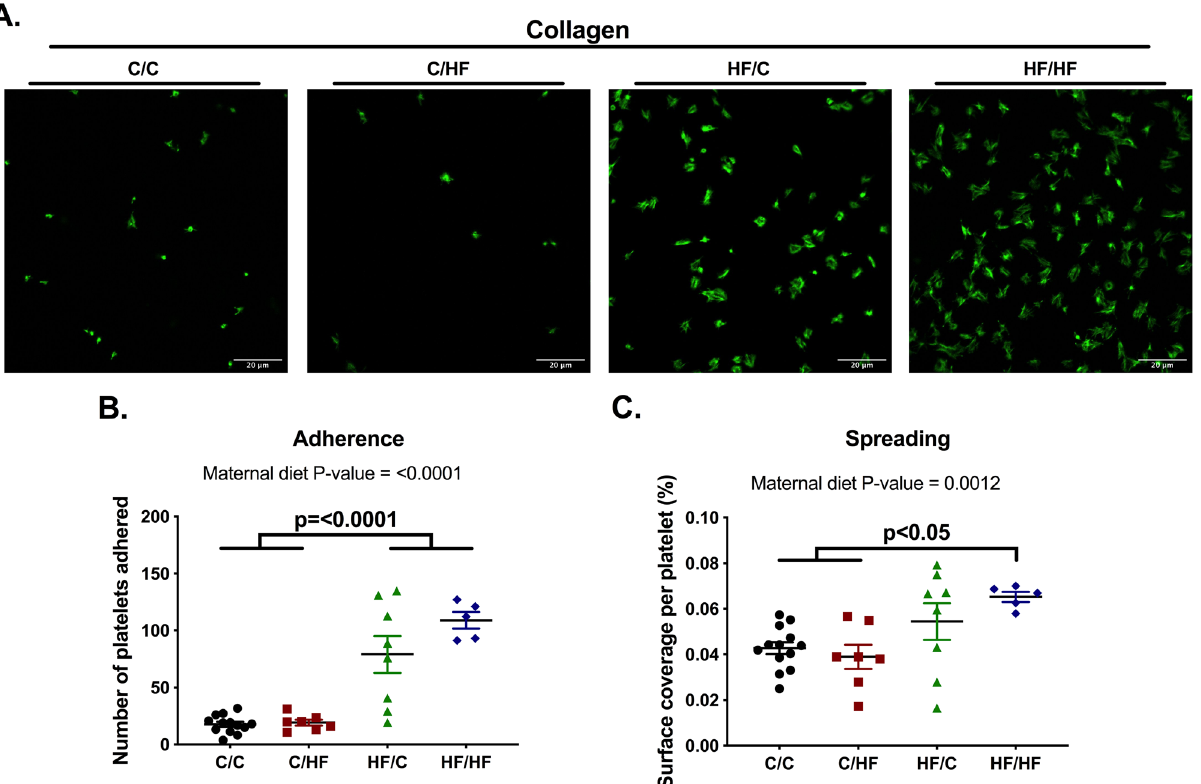
Figure 3. Maternal high-fat diet increased platelet spreading over collagen in male offspring. WP (2 × 10 7 platelets/mL) was left to adhere to coverslips coated with collagen and platelets fluorescently labelled for visualization. ( A ) Representative images of platelet spreading of each group. ( B ) Quantification of platelet adherence as number of platelets per field. ( C ) Platelet spreading as the total fluorescence of the field divided by the number of platelets. C/C, dam and offspring fed standard laboratory diet; C/HF dam fed standard laboratory diet and offspring fed high-fat diet; HF/C dam fed high-fat diet and offspring fed standard laboratory diet; HF/ HF dam and offspring fed high-fat diet. N = 5–13 mice from 4 to 6 litters per group. Graphs show mean ± SEM as well as individual values. Data analysed by two-way ANOVA with Tukey’s multiple comparisons test. P-values as well as the overall effects of maternal and offspring diet are reported where